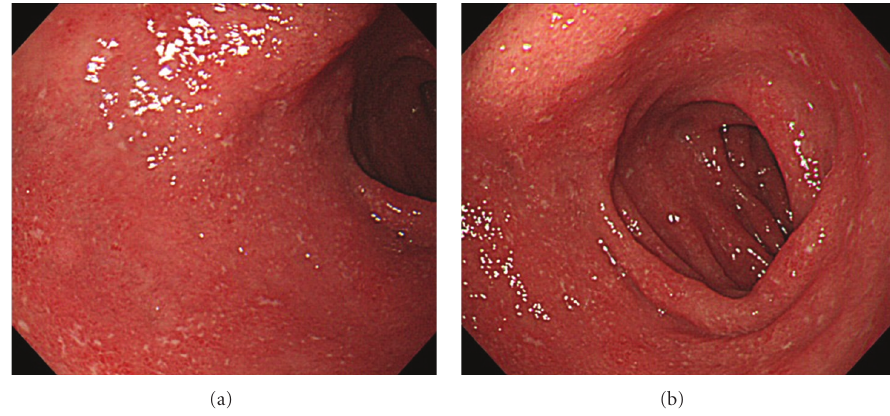
Figure 1: (a) Endoscopy of the upper gastrointestinal tract showed multiple small erosions and di ff use granular changes in the duodenal bulb that were similar in appearance to colonic lesions of UC. (b) Endoscopic findings of the descending portion of the duodenum also showed multiple small erosions and di ff use granular changes.